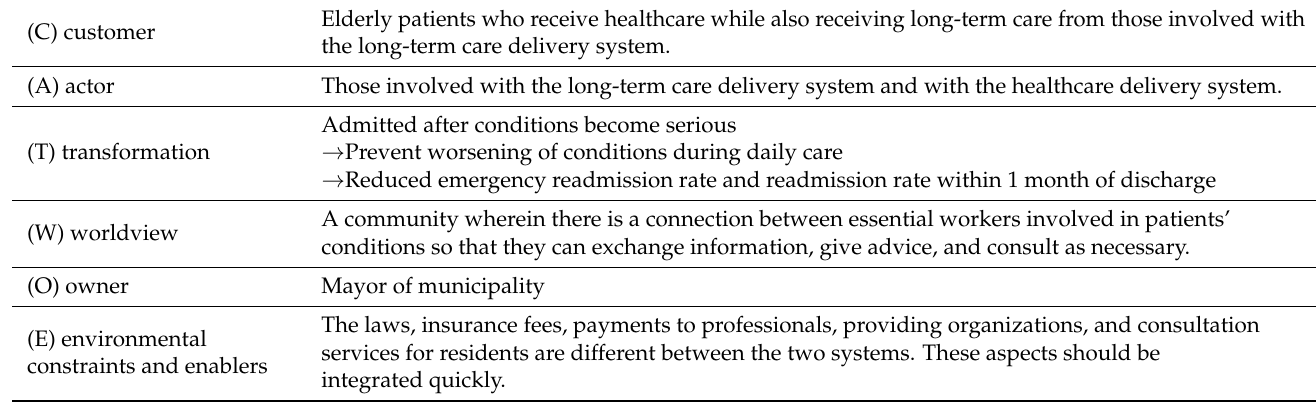
Table 2. CATWOE analytical results.